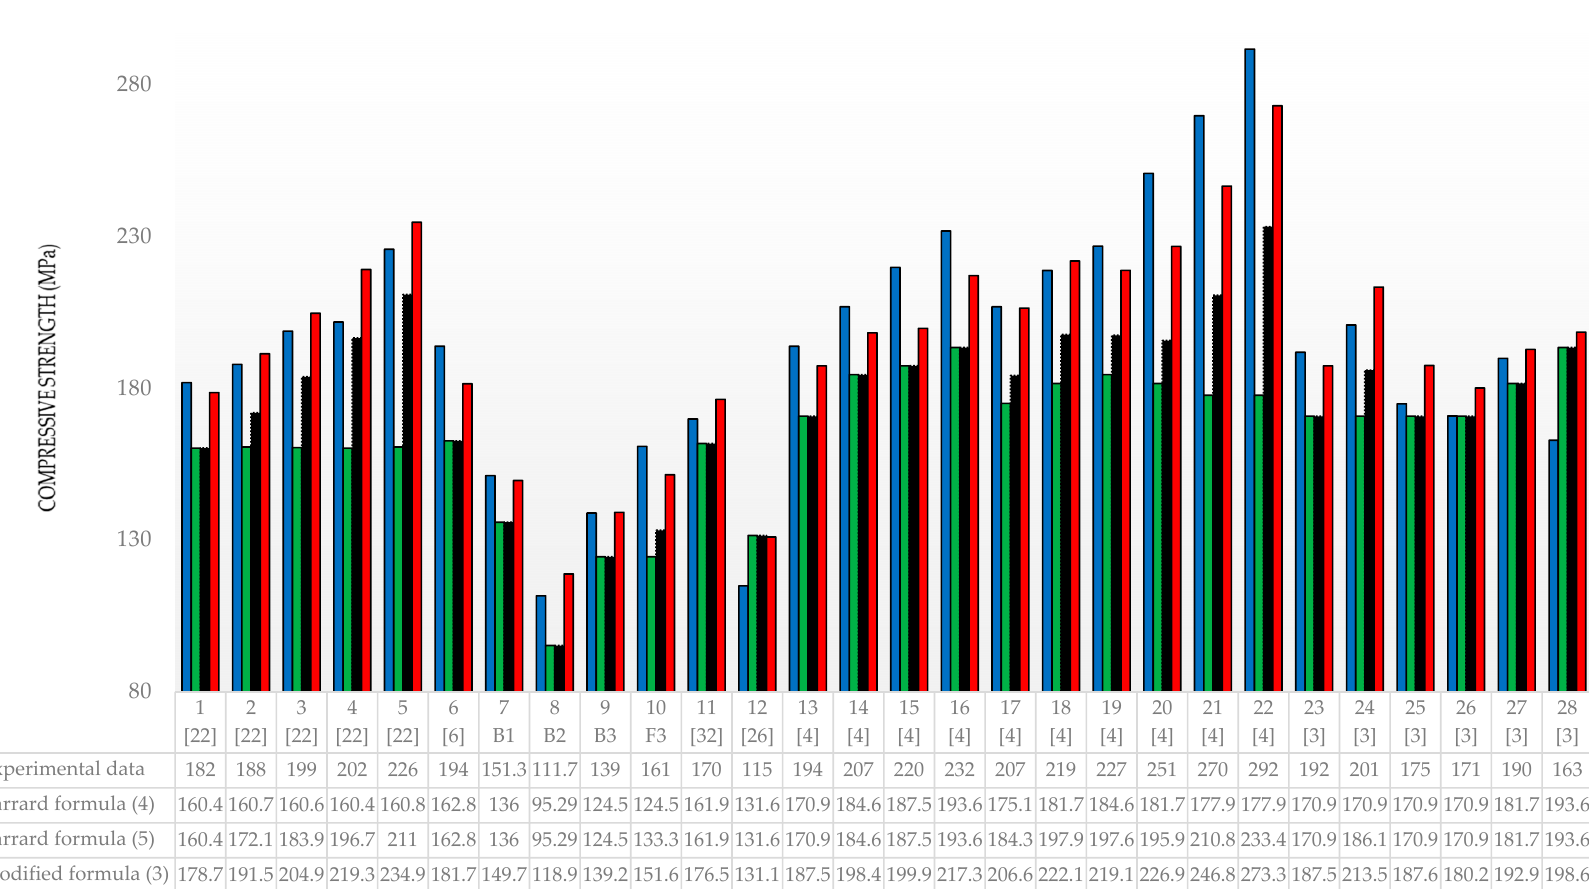
Figure 4. Experimental and design compressive strength for a different mix composition and formulas.